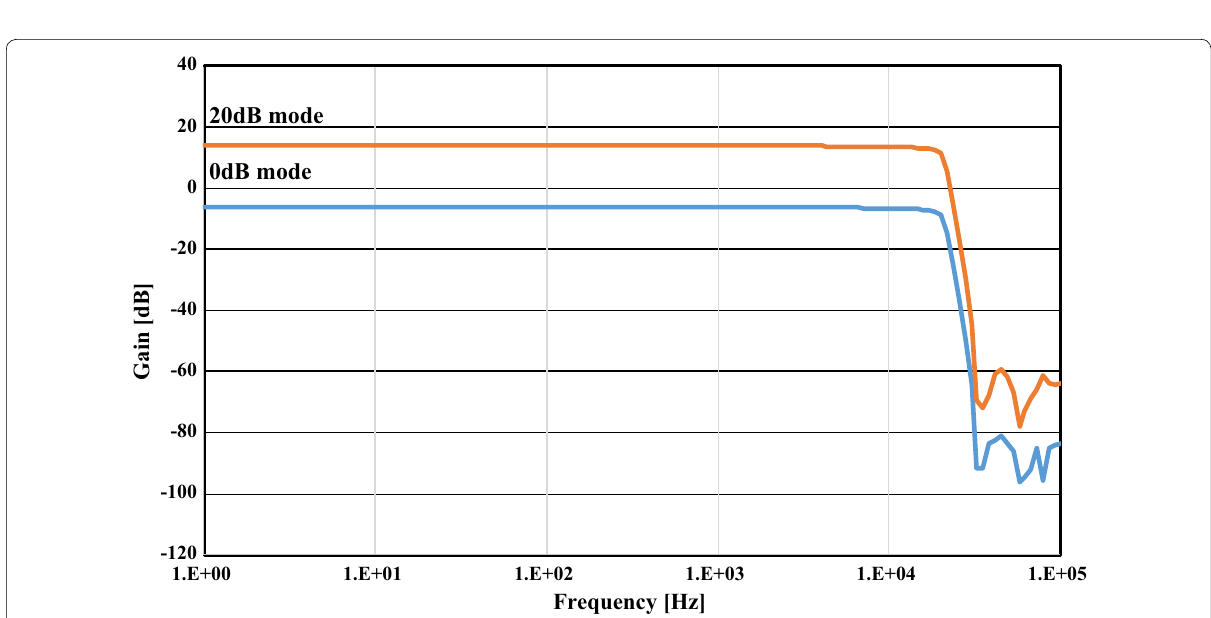
Fig. 13 Frequency response of the WFC/OFA(B) measured in the ground tests